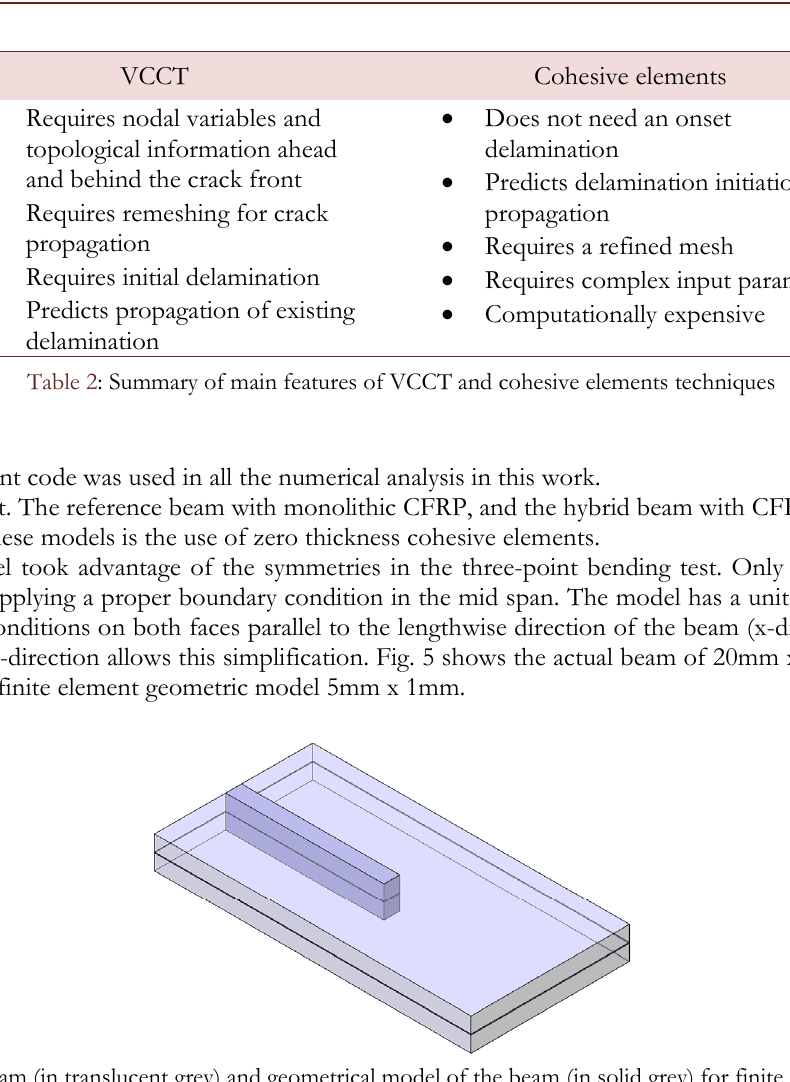
Figure 5: Short beam (in translucent grey) and geometrical model of the beam (in solid grey) for finite element simulation. The reference beam was modelled with one layer of zero thickness cohesive elements in the neutral fibre and the hybrid beam was modelled with zero thickness cohesive elements in the interface between the CFRP and the steel. The models have 8 elements per thickness in the CFRP and 40 elements across length with a bias ratio of 4, i.e. 40 th element in mid-span is 4 times smaller than the 1 st element in the extreme of the beam. The largest element has 0.460mm in length and the smaller element has 0.115 mm in